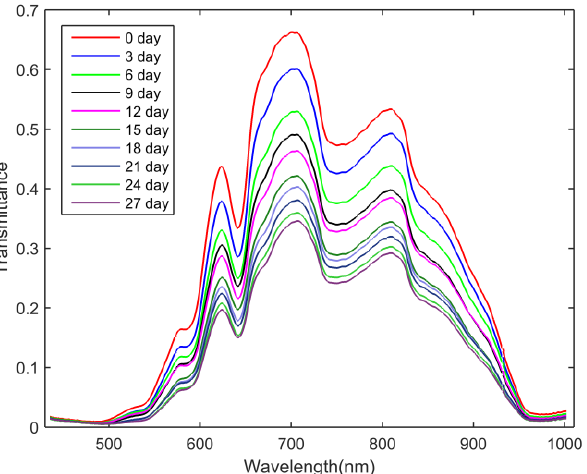
Figure 4. Mean transmittance spectra of egg samples at different storage times.